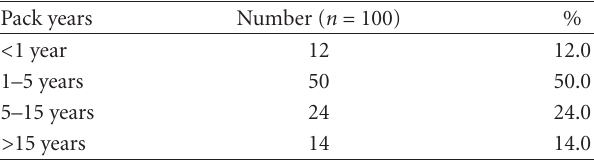
Table 2: Distribution of pack